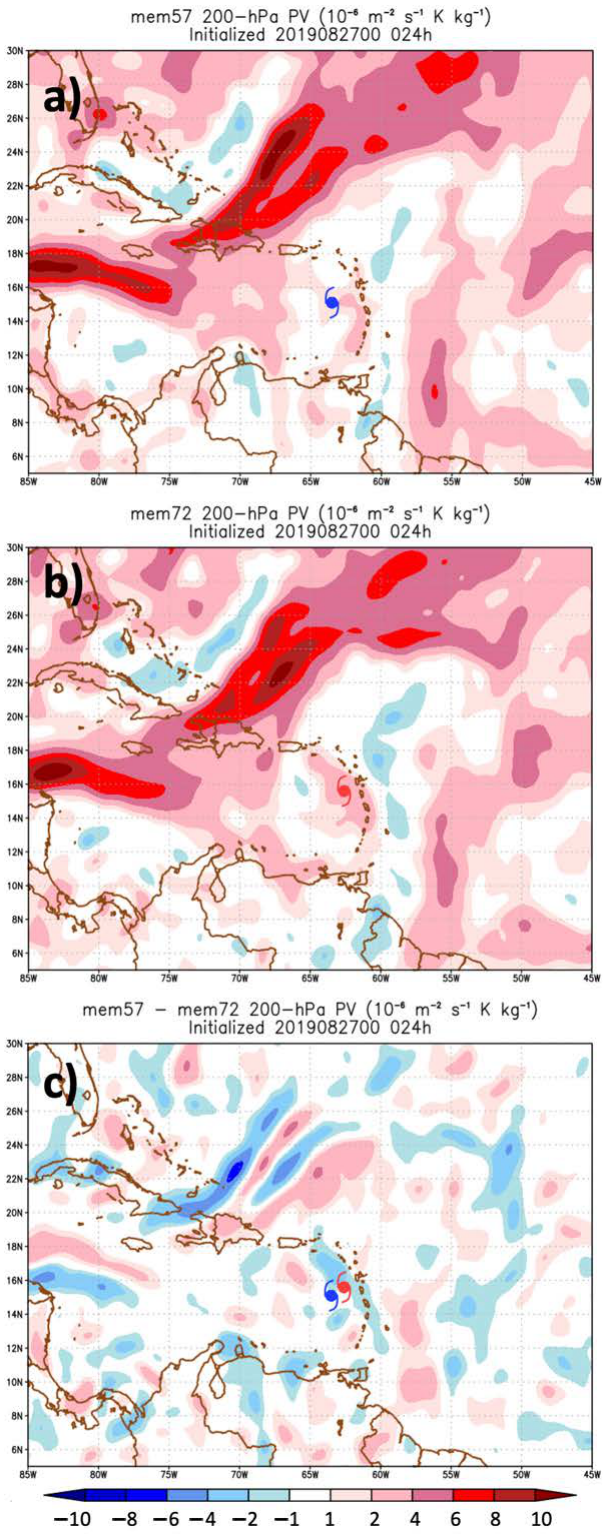
Figure 12. ( a ) 200-hPa potential vorticity (PV) (PVU, 1 PVU = 10 − 6 m − 2 s − 1 K kg − 1 ) for the weak member at 24 h. The model TC location is shown in blue. ( b ) As in ( a ), but for the strong member (shown in red). ( c ) PV difference at 24 h between the weak member and the strong member, with the TC locations shown in blue (the weak member) and red (the strong